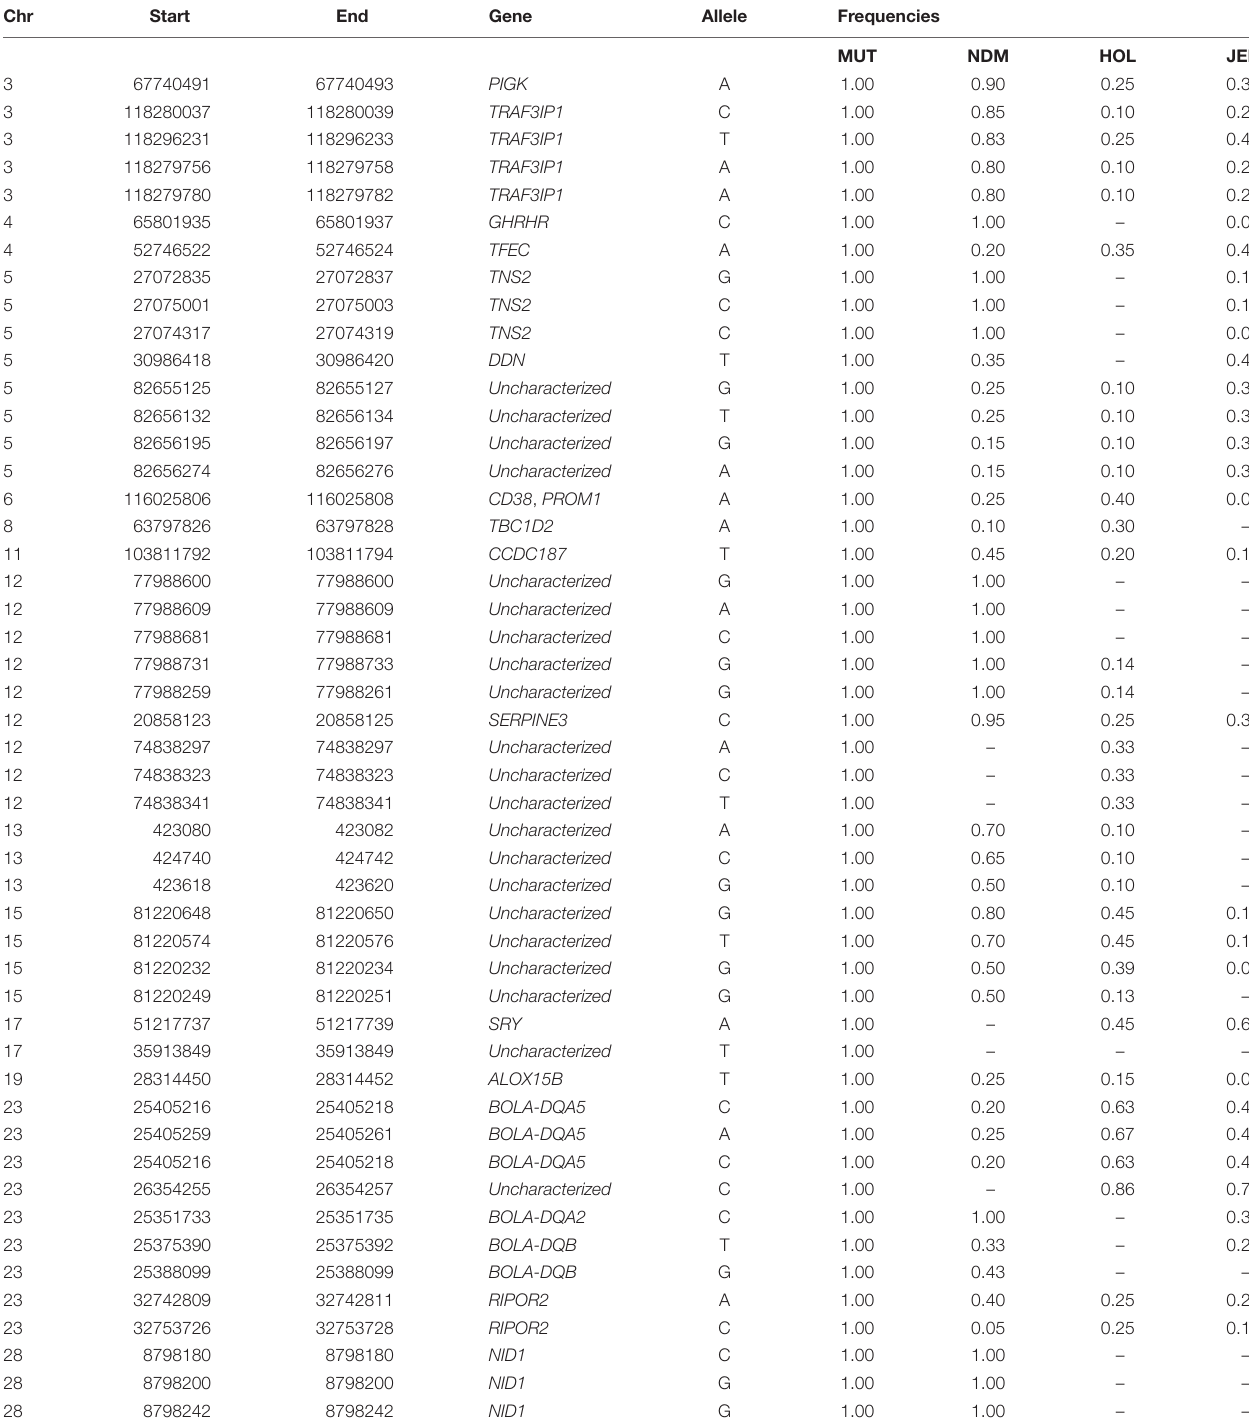
TABLE 5 | Genes containing fixed Muturu unique and shared missense variants.